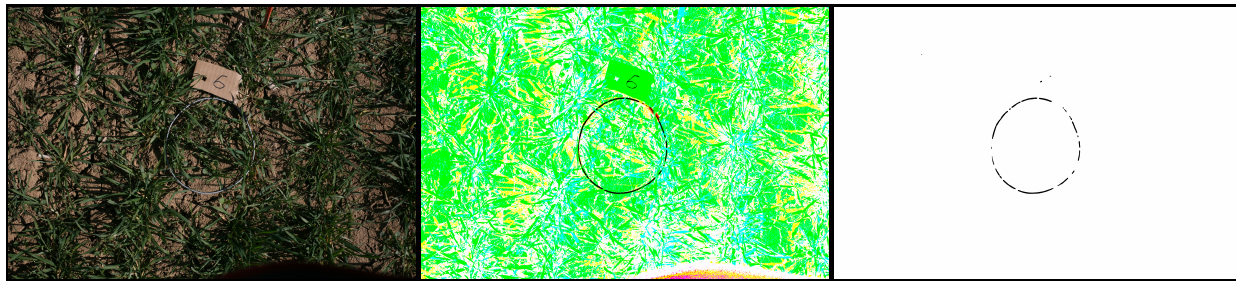
Figure 2. Image processing chain for frame segmentation based on colour. RGB input image (left); HSV thresholded channels combined (black: foreground, coloured/white: background), median filtered HSV colour segmentation